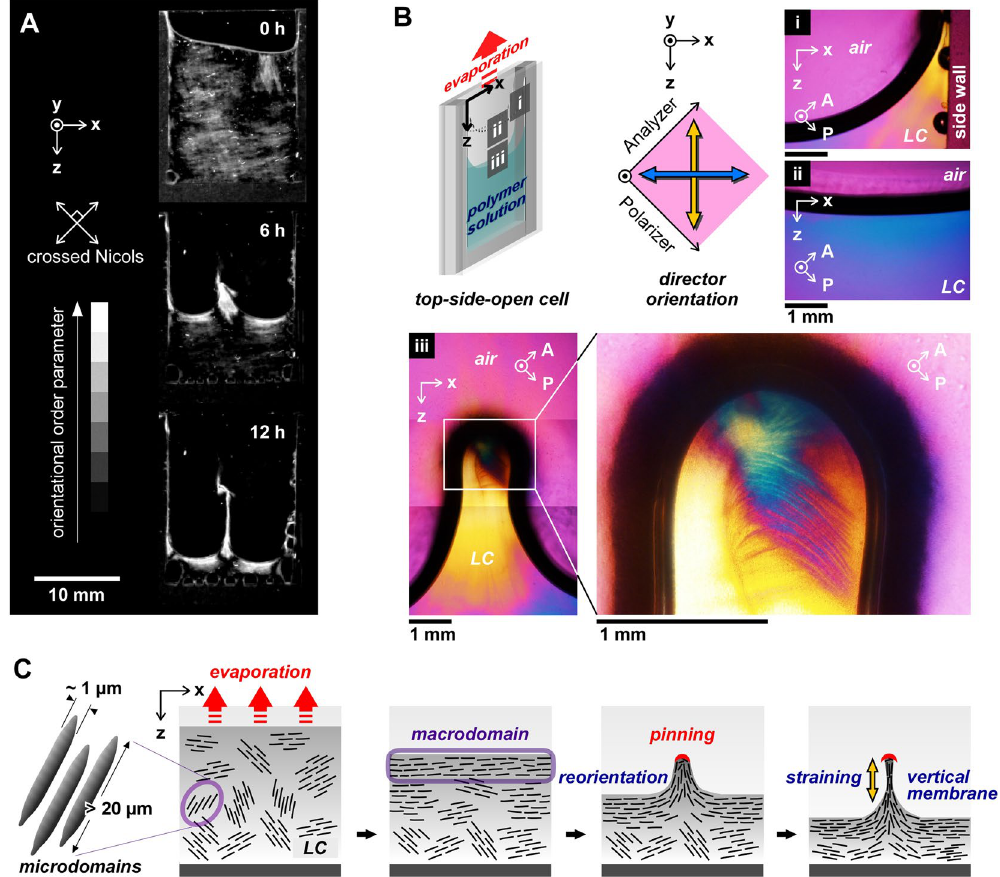
Figure 1. Interfacial instability of the polysaccharide liquid crystalline (LC) solution during drying in limited space. ( A ) Side views of a sacran solution during drying process under cross-polarized light. ( B ) Polarized microscopic images of the solution near the air-LC interface after 3 h (area i and ii) and 6 h of drying (area iii). The images were observed through a retardation plate, λ = 530 nm with crossed Nicols in the illustrated directions. ( C ) Schematic illustration for formation of vertical membranes by drying of a LC polymer solution in limited space with a narrow gap. Rod-like microdomains orient from the air-LC interface parallel to the contact line in the drying process. By drying in limited space, the non-equilibrium state between deposition and hydration near the interface causes pinning and vertical membrane formation between the narrow gap. The Z - direction is parallel to the direction of gravity. The gap between glass slides is ∆ y 0 = 1 mm. Initial concentration of sacran : 0.5 wt%. Drying atmosphere: 60 °C under air